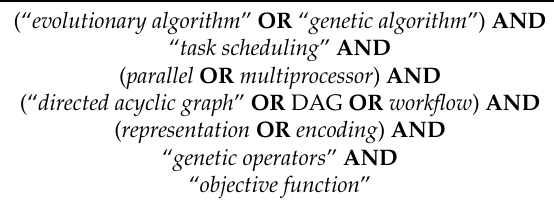
Table 1. Combinations used to compose the search key. (“ evolutionary algorithm ” OR “ genetic algorithm ”) AND “ task scheduling ”